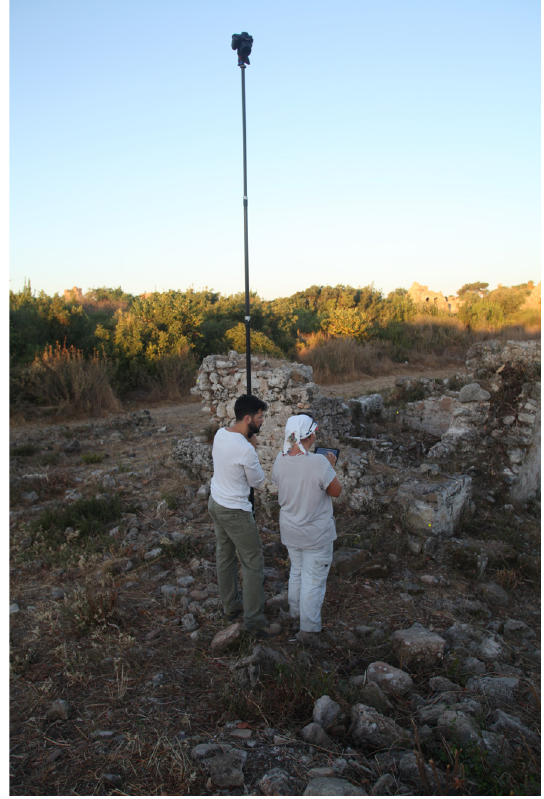
Figure 7. SfM data capture on mast/pole © ÖAW/IKAnt (A.